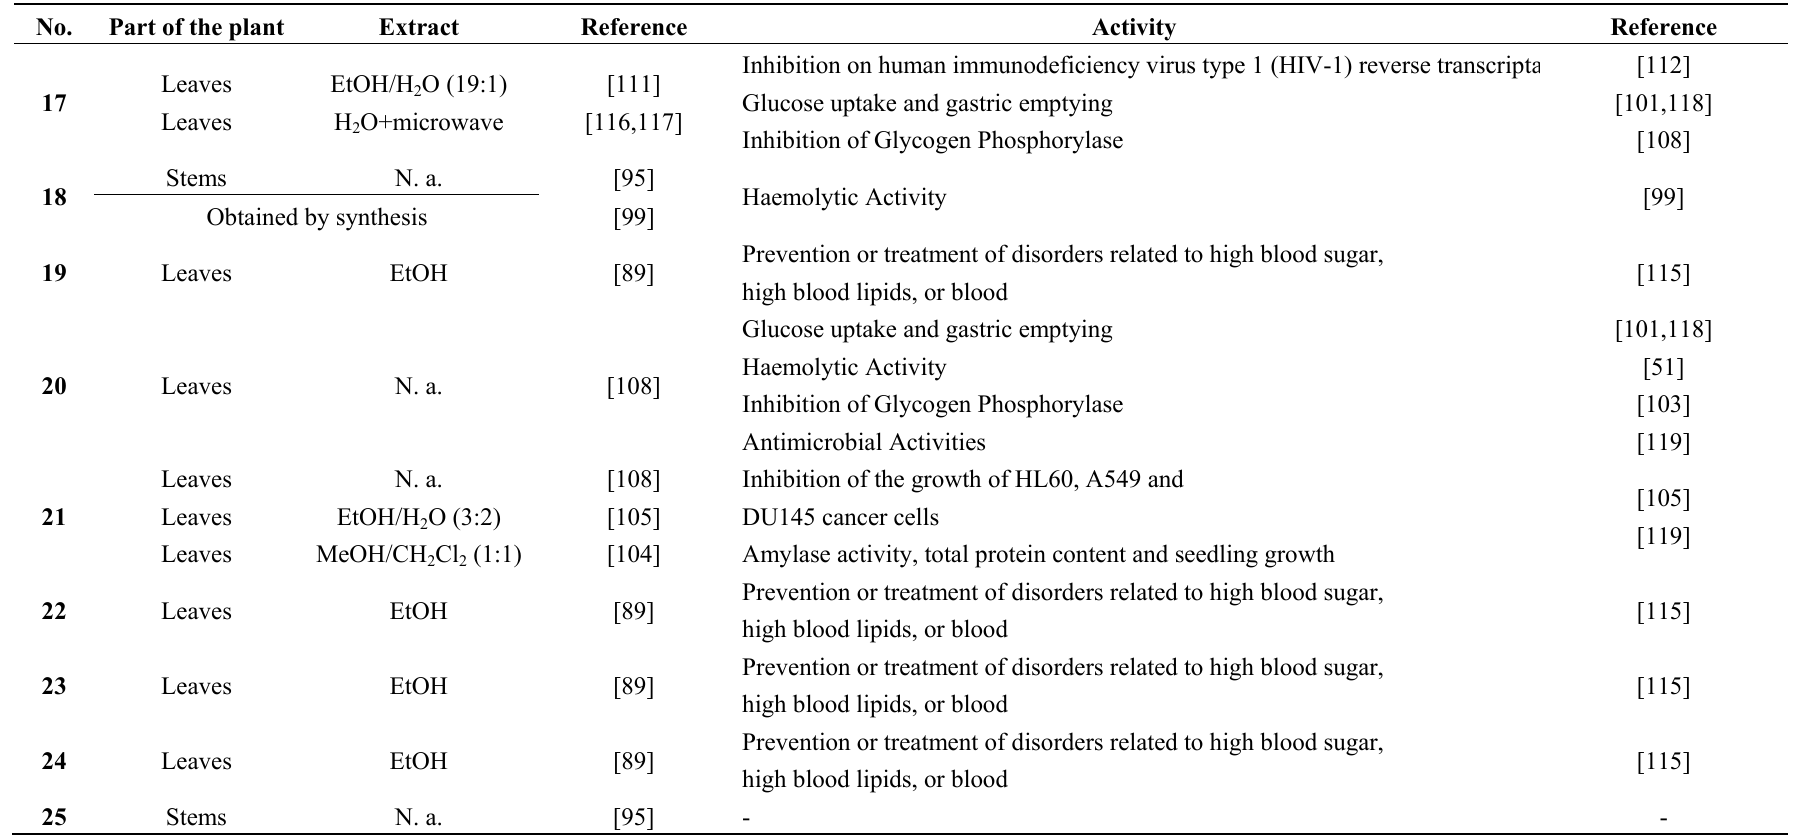
Table 9. Biological activity of compounds 17 – 25 and their natural